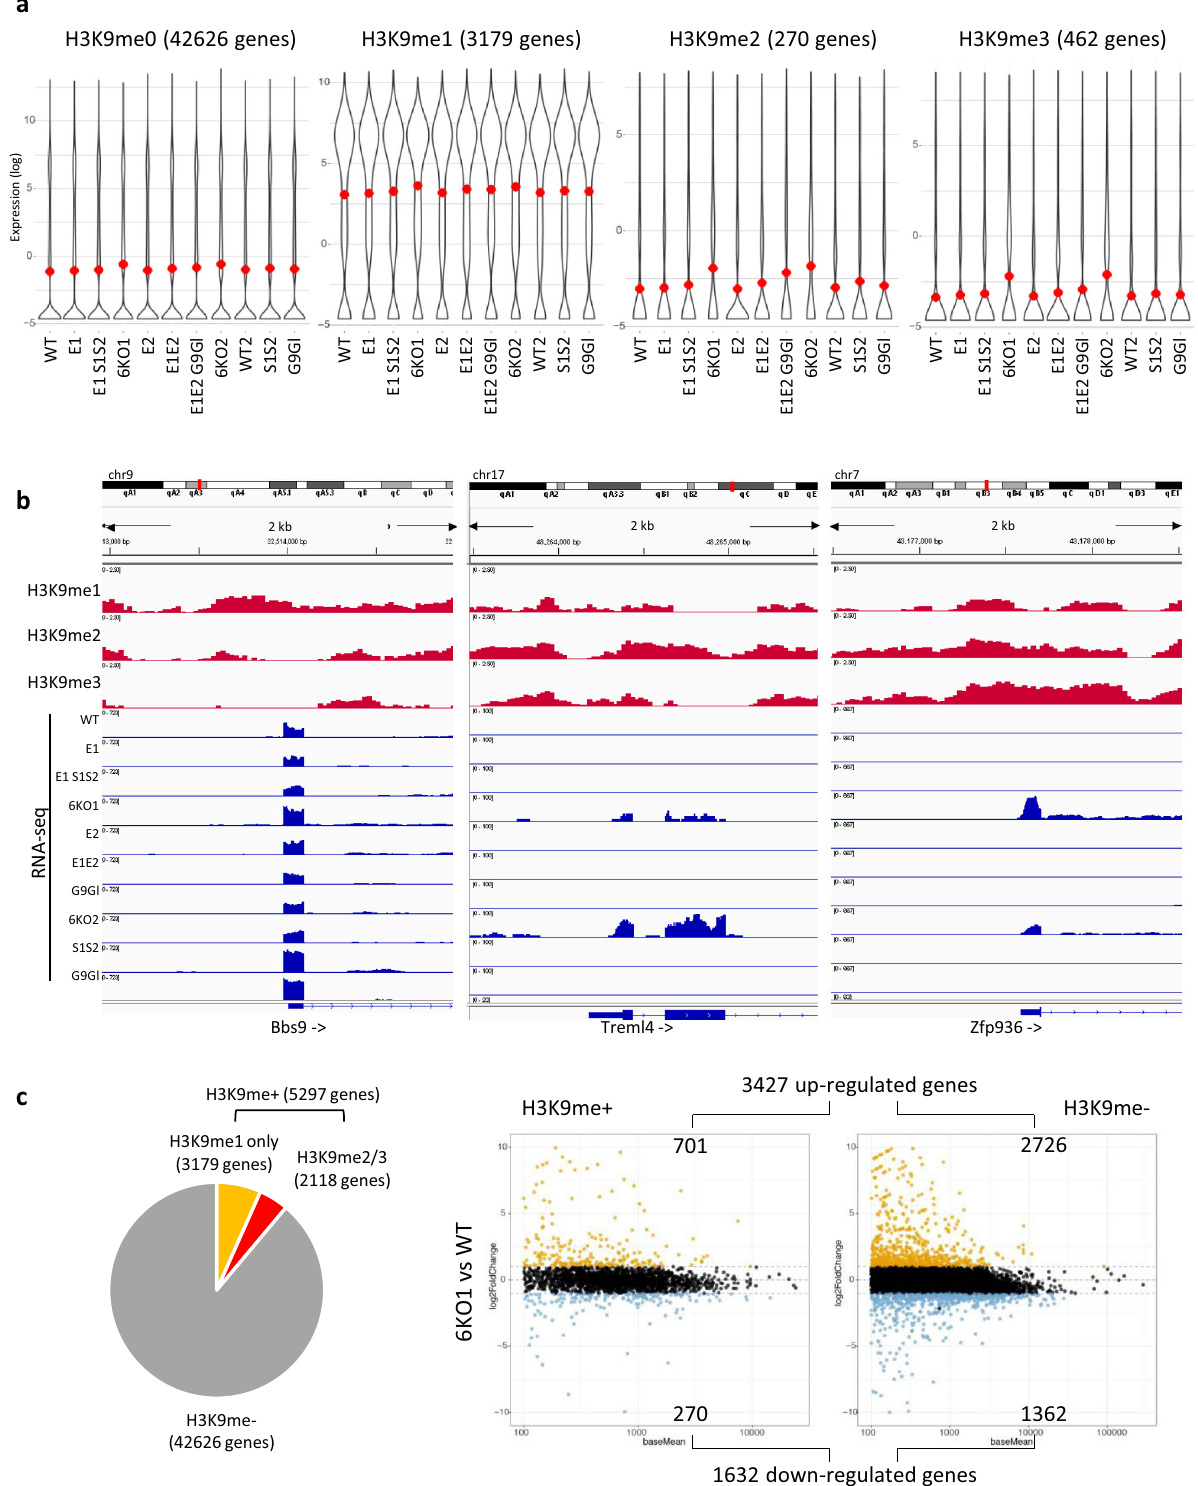
of the upregulated genes in the 6KO1 cells (701 of 3427 genes) (Fig. 5c) or 6KO2 cells (508 of 2517 genes), indicating an increased response of H3K9me-positive genes to loss of H3K9 methylation. By contrast, 80% of the genes derepressed in the 6KO1 mutants (2726 of 3427 genes) do not have H3K9 methylation at their promoters in WT cells. While some of these H3K9me-negative genes might still be regulated by H3K9